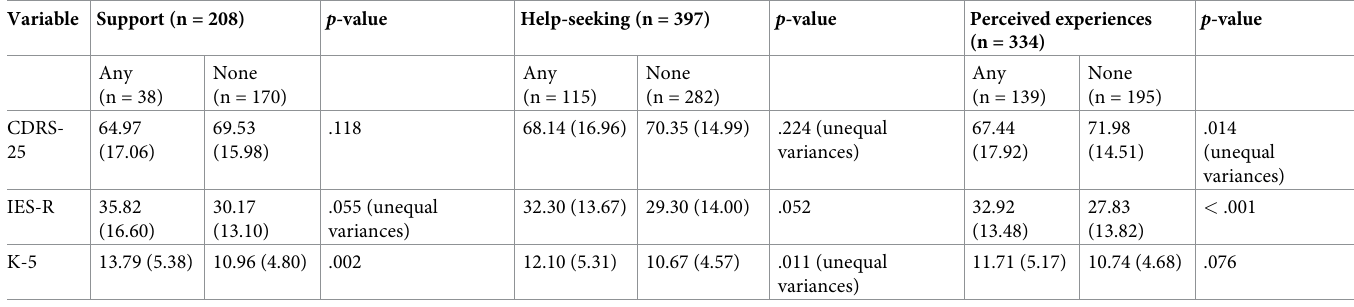
Table 7. Relationship between perceived support, help-seeking, and other event related experiences with the Blockade and resiliency, traumatic symptoms, and distress. Variable Support (n = 208)